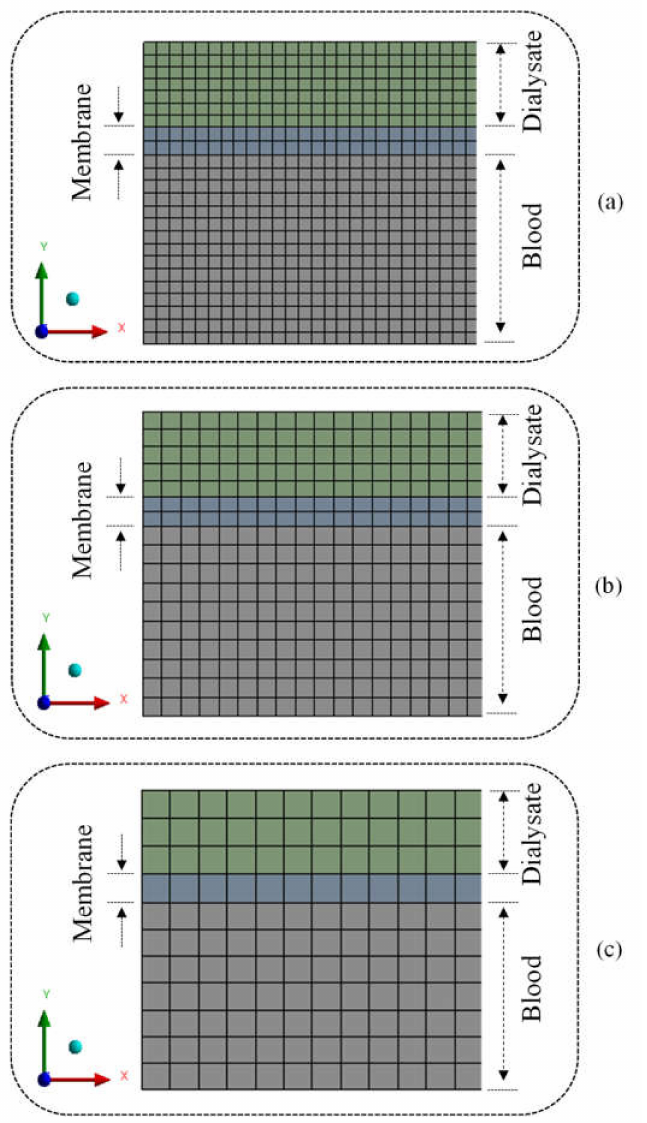
Figure 5. Details of the meshes used in the simulations ( a ) M 1 , ( b ) M 2 , and ( c ) M 3 .